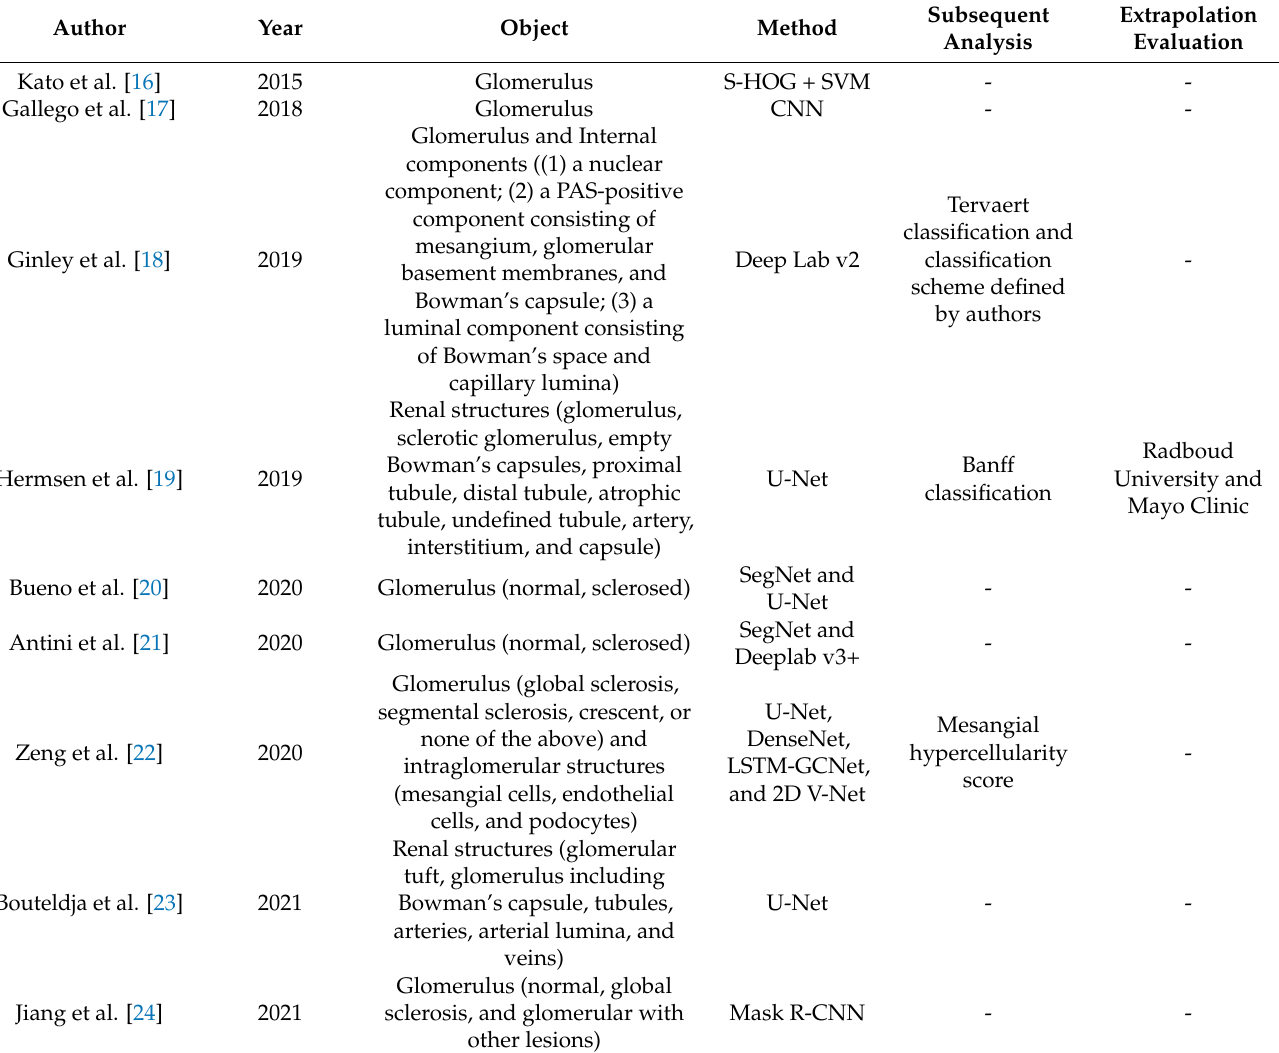
Table 1. Previous studies for glomerular segmentation from